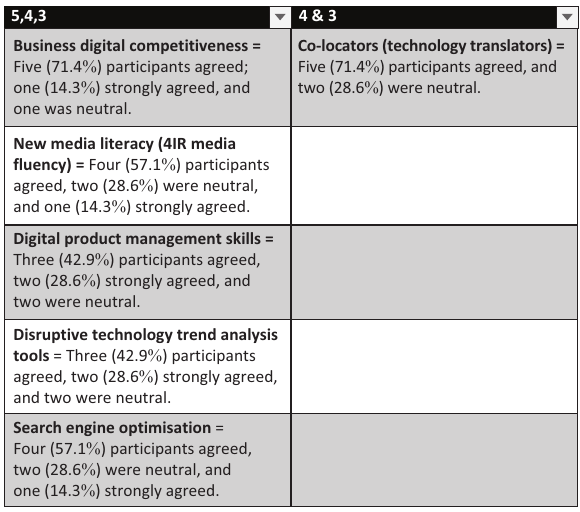
Co-locators (technology translators) = Five (71.4 % ) participants agreed, and two (28.6 % ) were